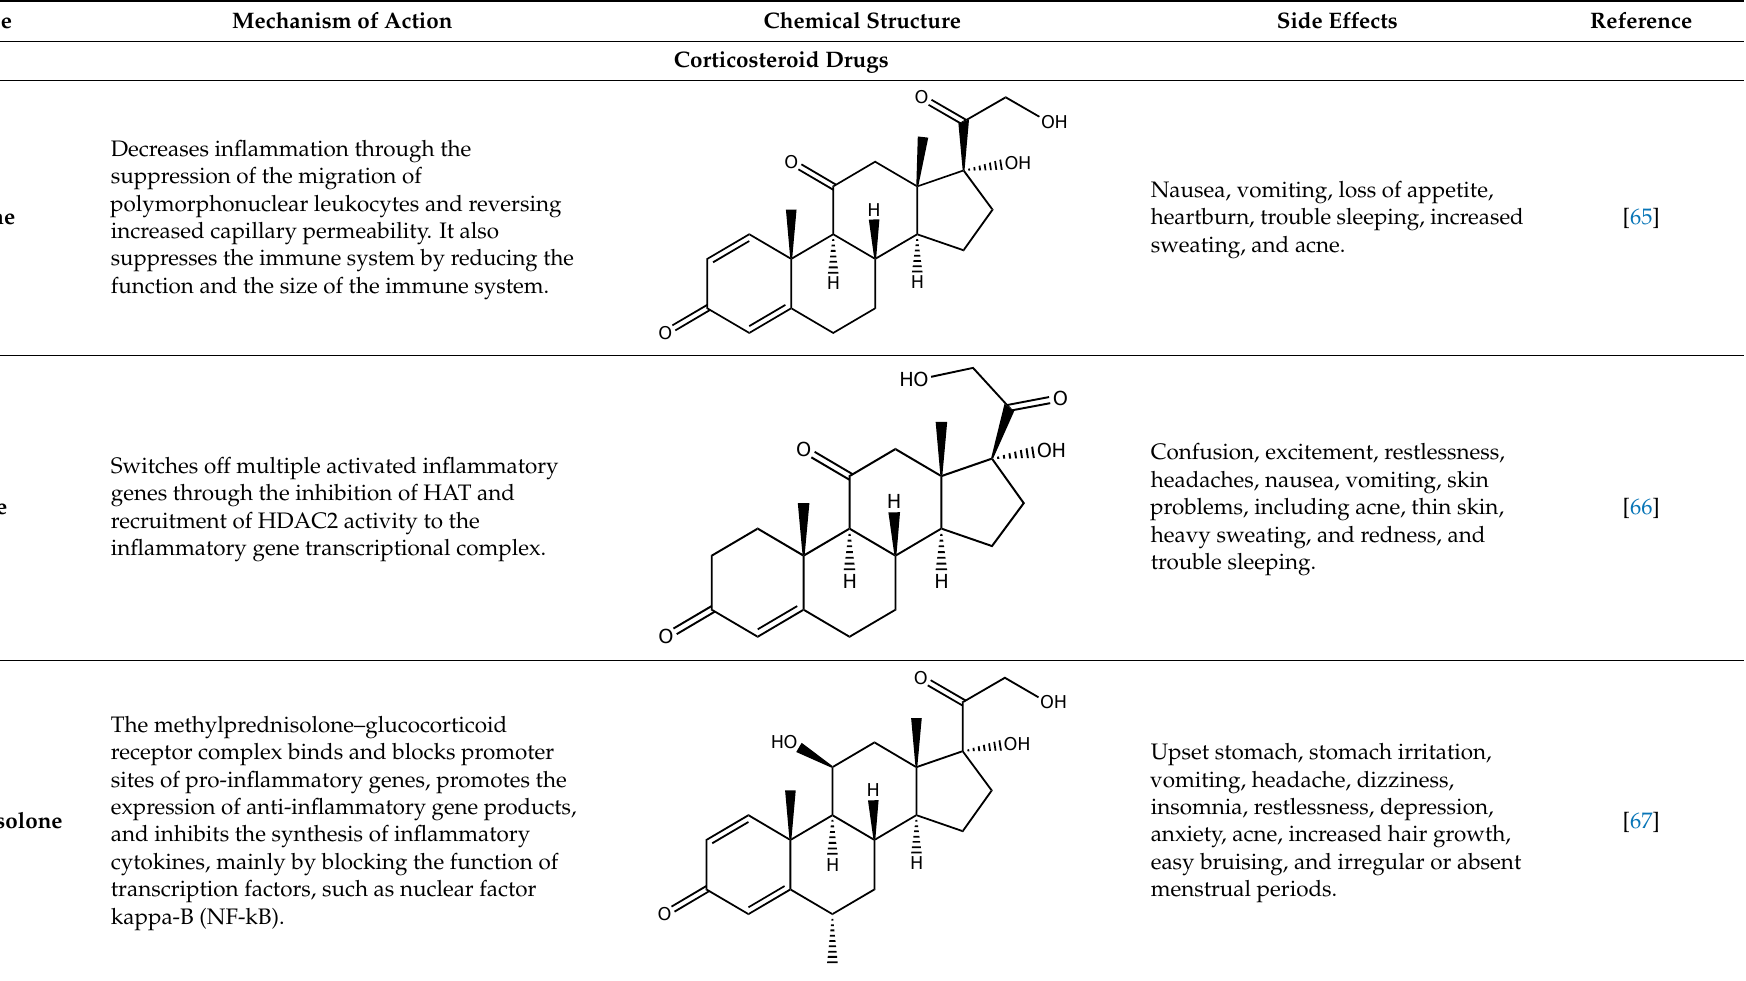
Table 2. Mechanism of action, structure, and side effects of some steroidal and non-steroidal anti-inflammatory drugs.